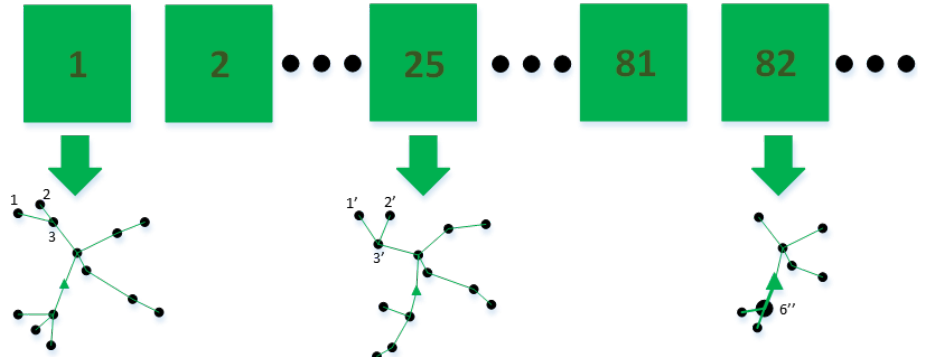
Figure 1. Example with similar mini-grids. The black dots in the network layouts represent the consumers. The green triangles represent the generation sites, and the green lines represent the low-voltage (LV) distribution network.